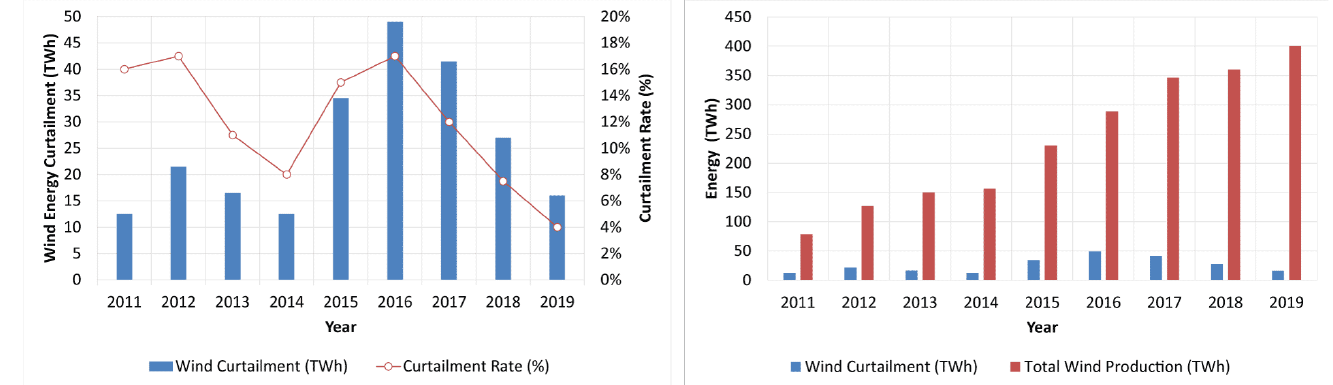
Figure 6. Wind energy curtailment in China 2011–2019: curtailed energy production and curtailment rate ( left ), curtailment compared to total wind energy production ( right ). Source: [56–60].